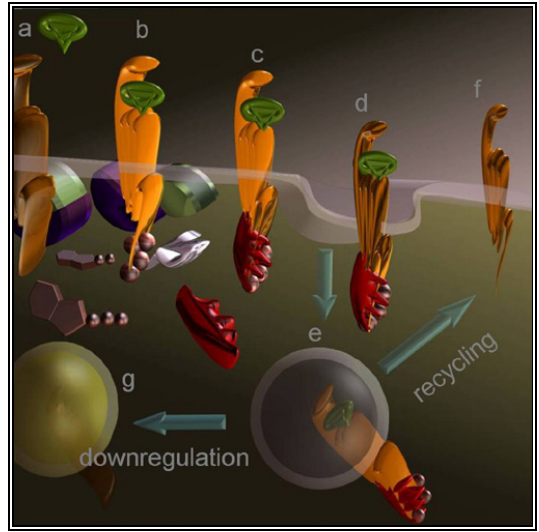
Figure 3. GPCRs desensitization occurs concurrently its activation. Agonist (green) binding destabilizes ( a ) the inactive state and ( b ) the receptor promotes G protein activation acting as a GTP exchange factor. At the same time, kinases (white) phosphorylate the receptor on multiple sites and ( c ) a cytosolic adaptor named arrestin (red) masks the GPCR domain binding to the G protein. Arrestin interacts with several proteins, including elements of the endosomal machinery that ( d ) recruit the GPCR to clathrin-coated pits promoting its endocytosis. ( e ) Once endosomes are formed, the GPCR can either be ( f ) dephosphorylated and return to the cell surface for another round of activation or ( g ) become proteolyzed thus reducing the number of available receptor